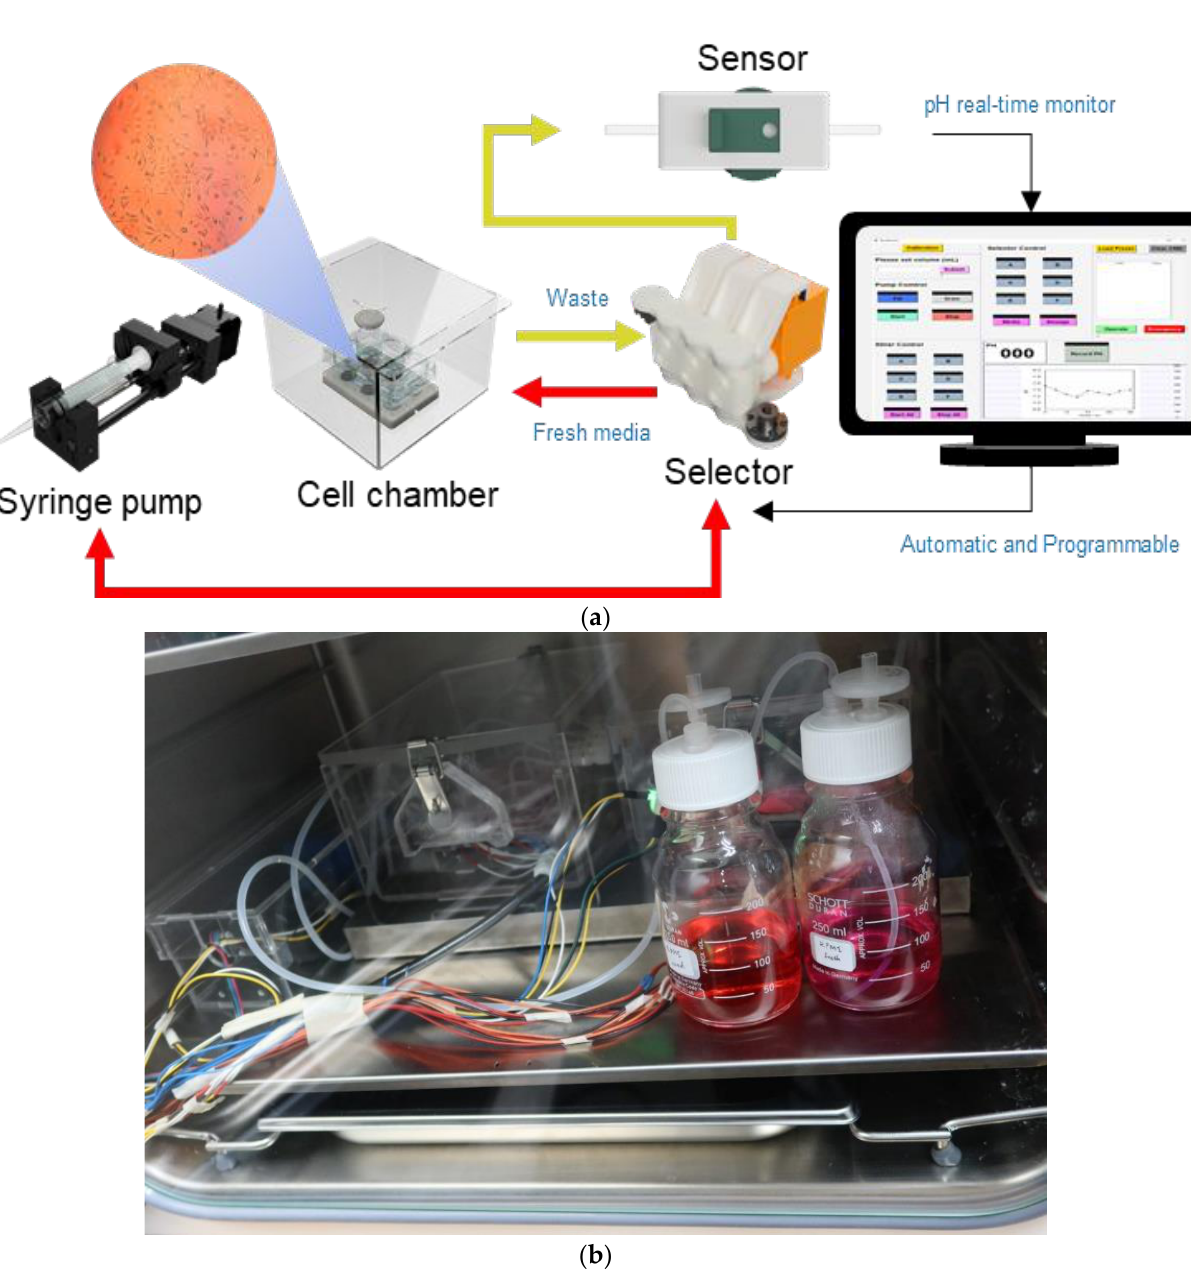
Figure 1. A bioreactor with a pH monitoring system: ( a ) a schematic diagram showing components of the bioreactor; ( b ) a photo of the bioreactor inside an incubator.